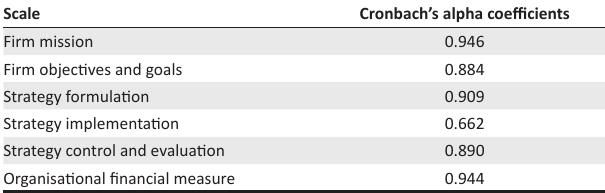
TABLE 1: Cronbach’s alpha coefficients.